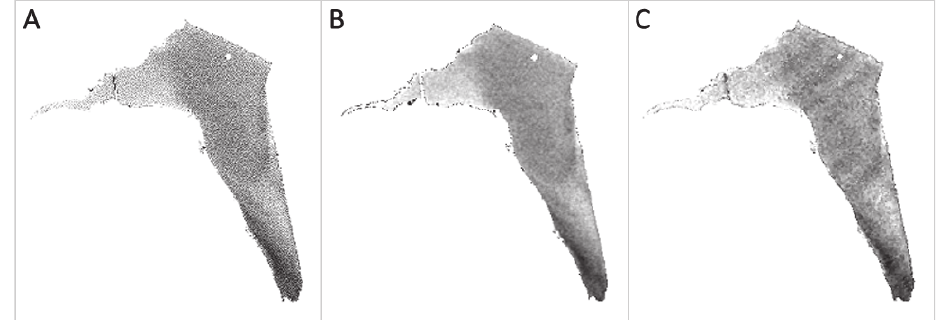
Figure 2 - Original refl ectance image of band 3 (a) , the one smoothed with mean fi lter (b) , and smoothed with median fi lter (c)